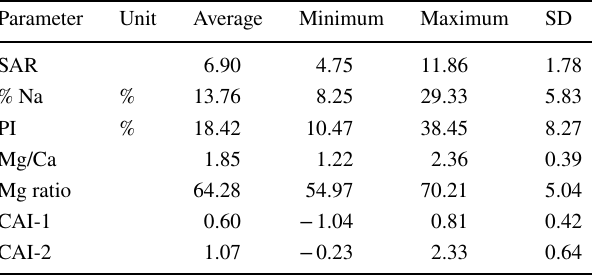
Table 5 Statistical summaries of chemical data of groundwater sam- ples, Surat